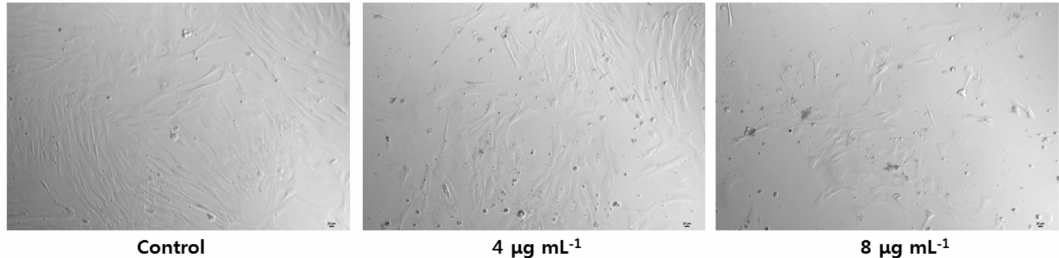
Figure 3. Cell morphology following treatment with GO-AgNPs. Caprine fetal fibroblast cells (CFFCs) were treated with 0, 4, and 8 µ g/mL of GO-AgNPs for 24 h and then visualized under a phase-contrast microscope (magnification, 100 × ). Scale bar = 20 µ